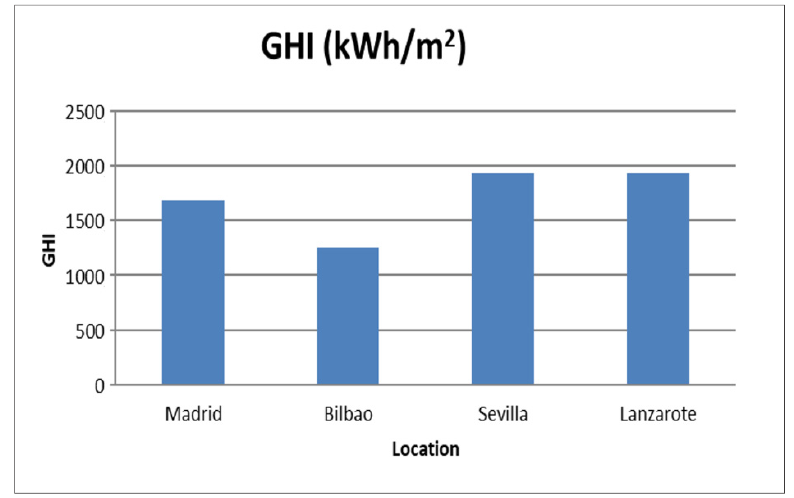
Figure 6. GHI for each of the studied locations.